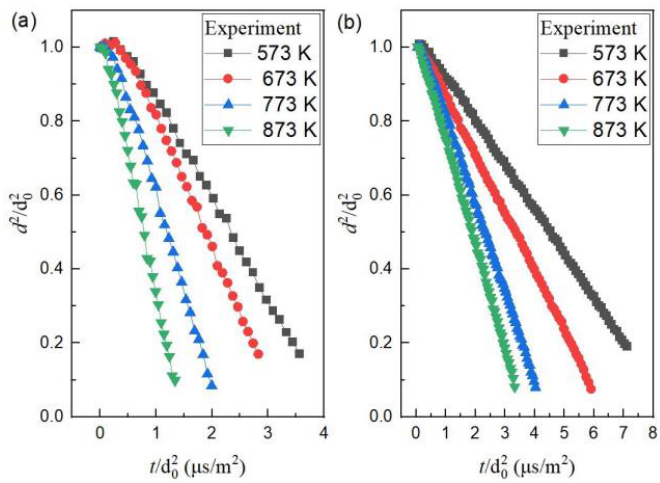
Figure 3. The evaporation curves of mono-component droplets at different ambient temperatures in experiments: ( a ) n-decane; ( b ) ethanol.